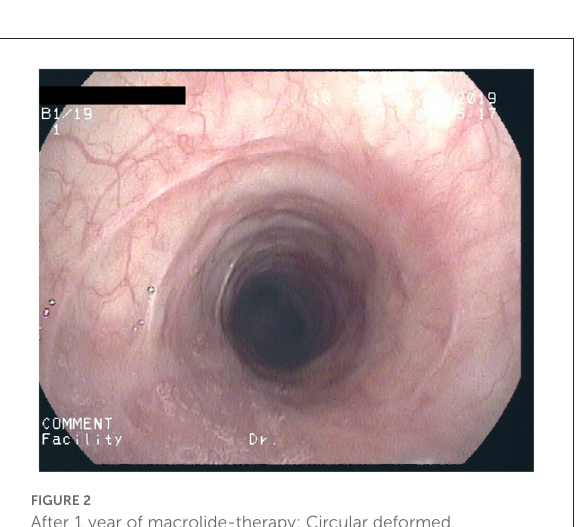
FIGURE2 After 1 year of macrolide-therapy: Circular deformed, non-stenotic trachea with considerably diminished scar